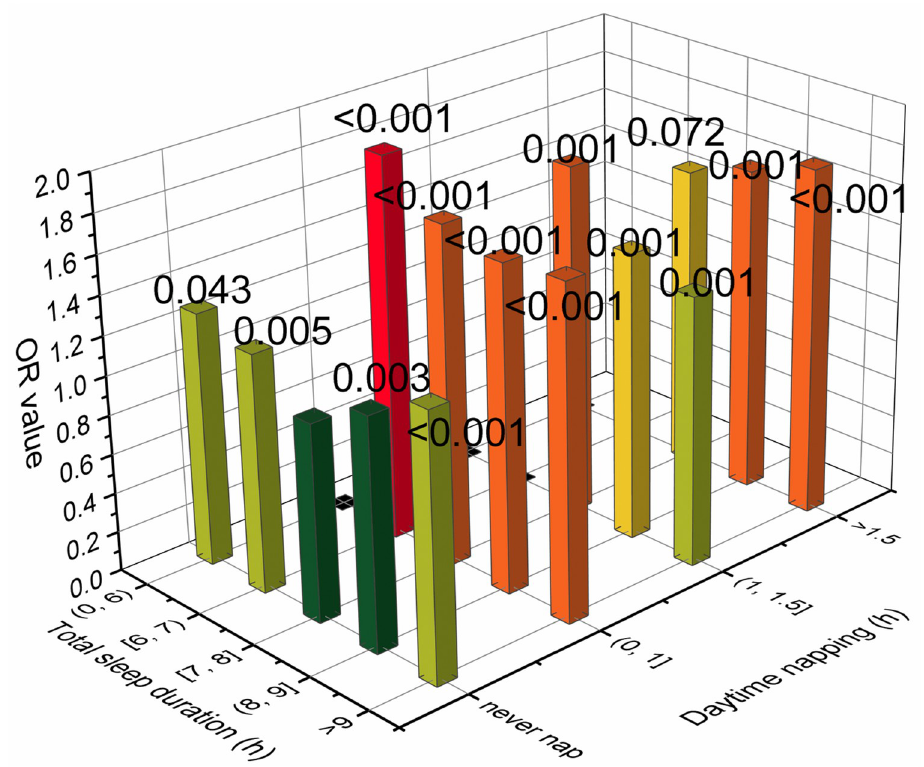
Fig 3. Joint analysis of total sleep duration and daytime napping duration in relation to the risk for microalbuminuria. The multivariate ORs for microalbuminuria were adjusted for age, sex, BMI, HC, WC, alcohol consumption and smoking habits, physical exercise, TG, TC, HDL, LDL, GGT, blood glucose and blood pressure. The asterisk denotes that the result was significantly different from 7–8 hours of sleep duration per day without daytime